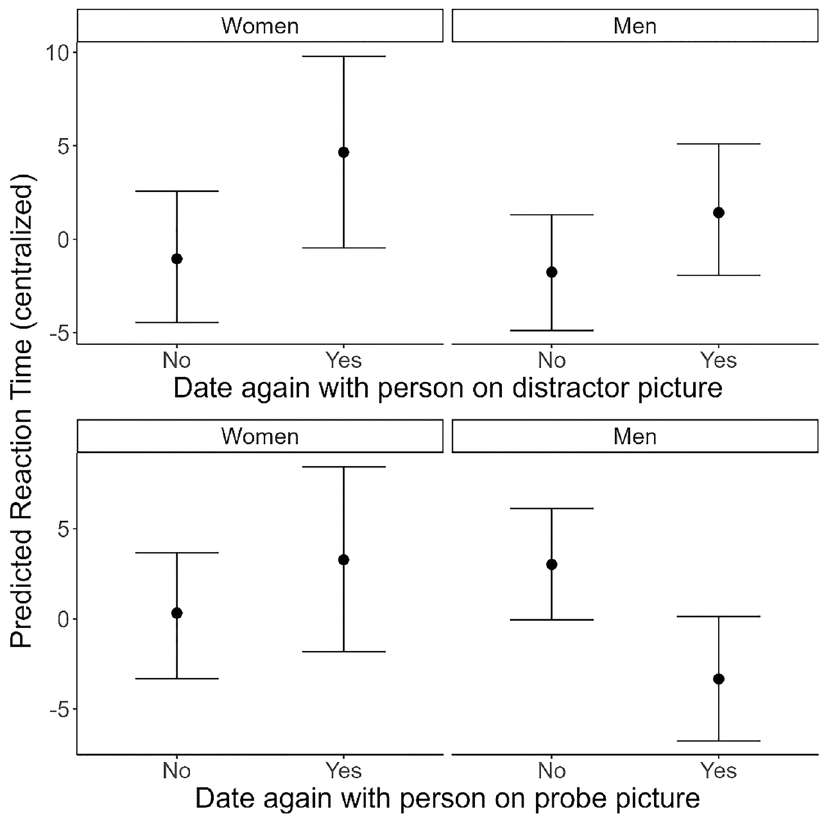
Figure 2. Conditional effect plot showing the effect of Date outcome on Reaction Time (RT) separate per Gender . Values are conditioned on the other predictor set to “No”. Error bars represent 95% Credible